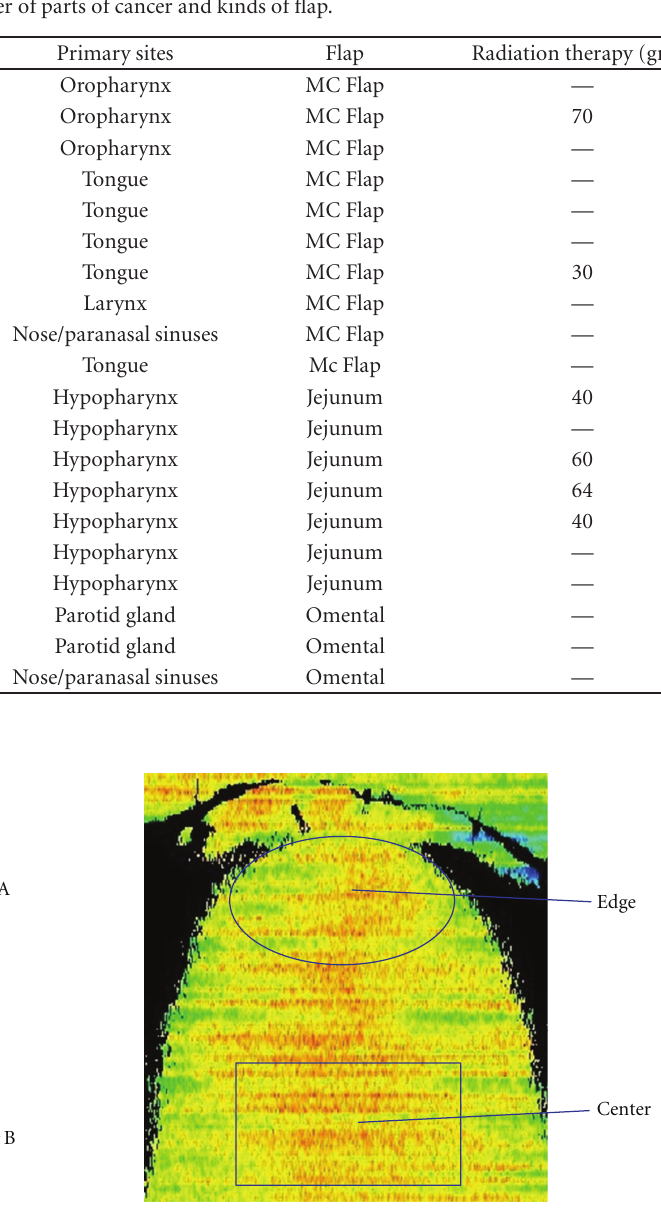
Figure 3: Photograph of measuring blood flow in the jejunal flap. (A) Device for discharging the laser and the mirror. (B) Jejunum. (C) Intubation tube.